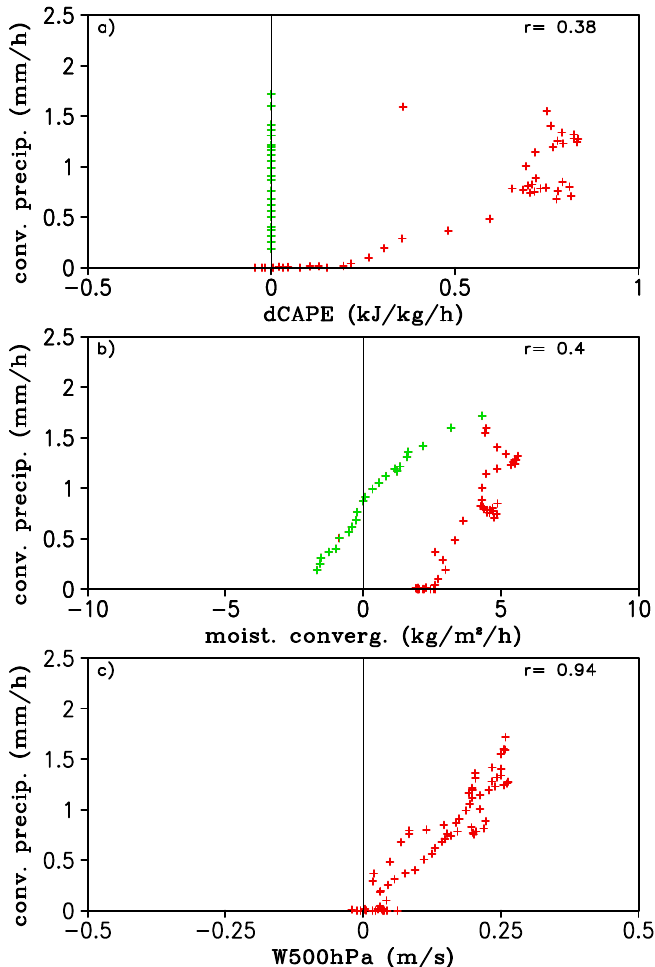
Figure 7. Scatter plots of convective precipitation rate (mm / h) against ( a ) vertical velocity at 500 hPa (m / s), ( b ) moisture convergence (kg / m 2 / h), and ( c ) large-scale CAPE change (kJ / kg / h) over 256 km subdomain. The green crosses in ( b ) and ( c ) are data points with dCAPE and CAPE equal to zero.